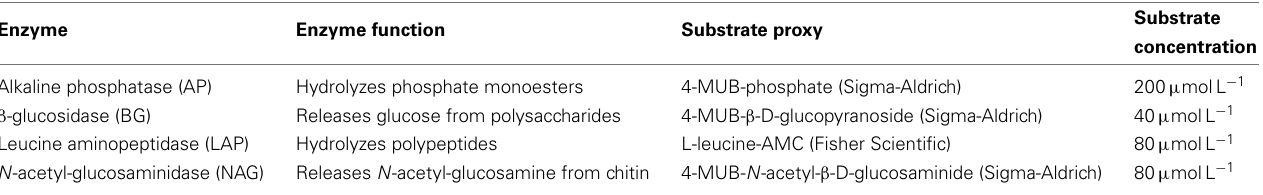
Table 1 | Enzymes, substrates, and assay